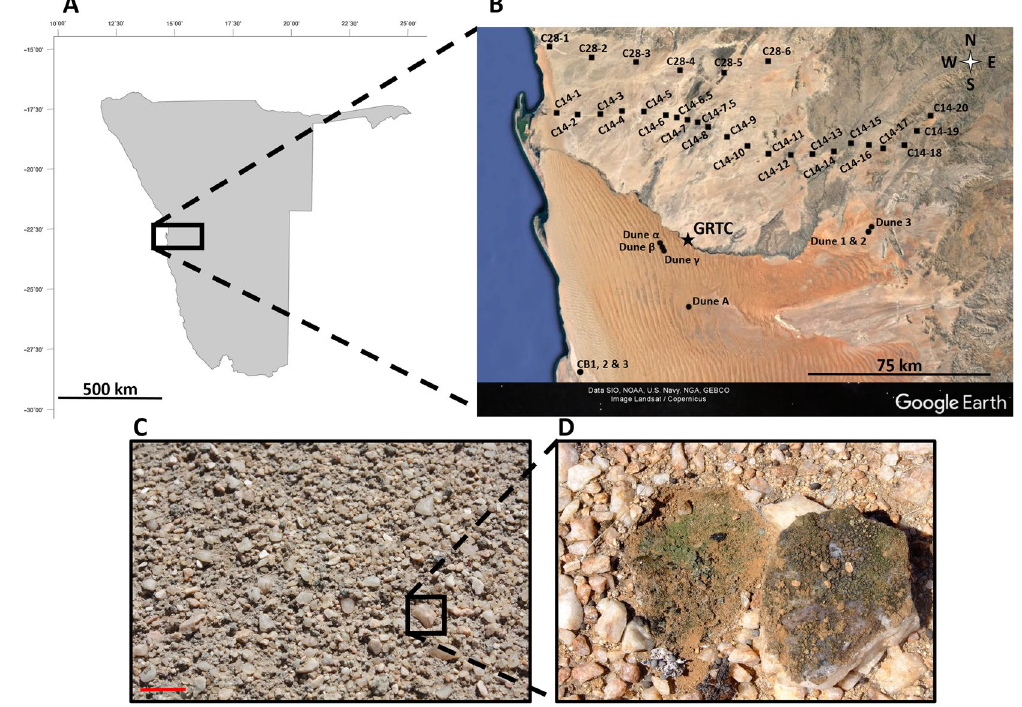
Figure 1. Map of Namibia ( A ) showing the distribution of the sampling sites ( B ) in the Central Namib Desert. ■ Gravel plain. ● Dune. ( C ) Photograph of the Namib Desert gravel plain quartz rock pavement. Scale bar represents 10 cm. ( D ) Close-up picture of an overturned quartz rock. The green biomass the ventral surface of the rock and on the soil just under the overturned rock is indicative of a cyanobacterial-dominated microbial community and primary production. The map of Namibia was adapted from one obtained from the GinkgoMaps-project (http://www.ginkgomaps.com/maps_namibia.html) and the Central Namib Desert map was produced with Google Earth, © 2016 DigitalGlobe. Photo courtesy of J-B Ramond and DA Cowan